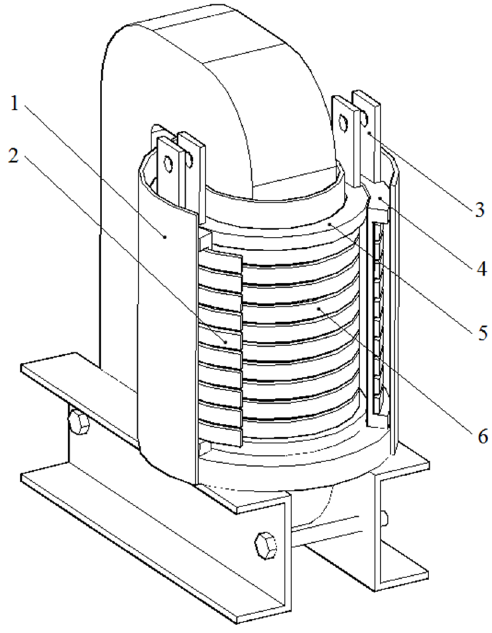
Table 1. Parameters of 8.5 kVA and 13.8 kVA HTS Transformers.